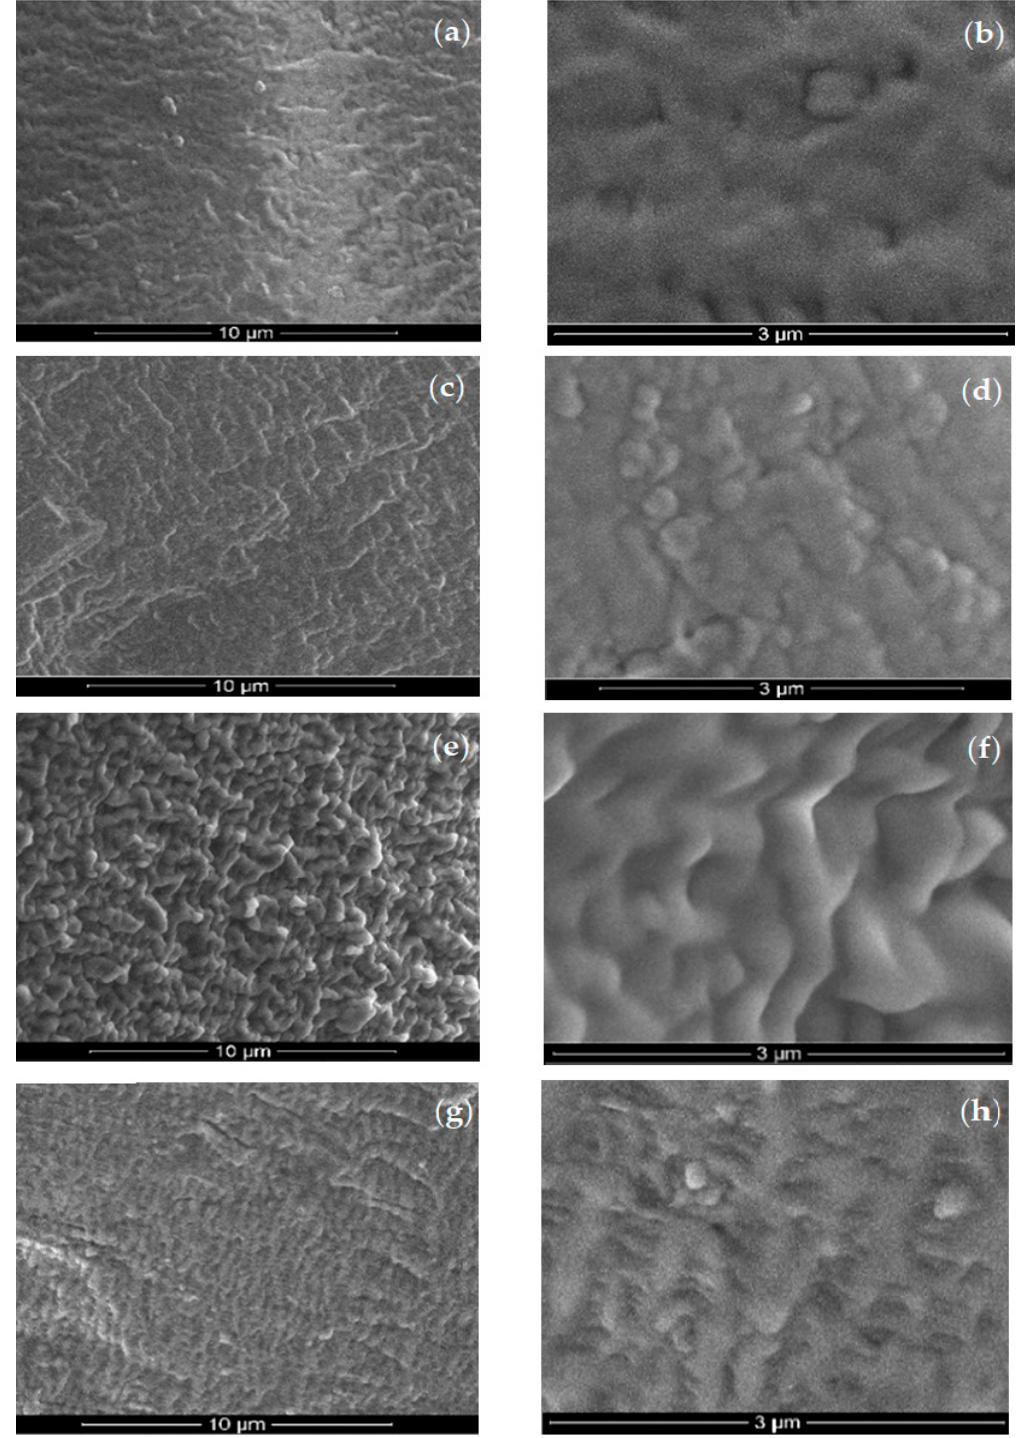
Figure 4. Scanning electron microscopy (SEM) of the obtained composite membranes (Os–PPM):